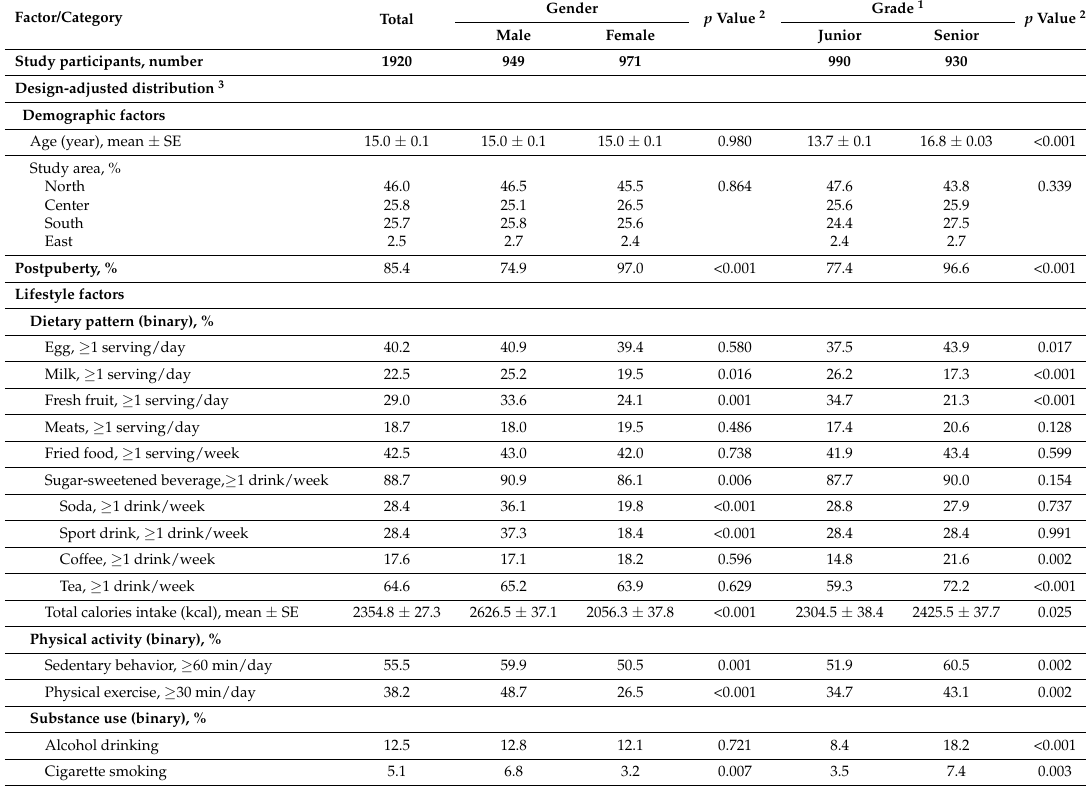
Table 1. Distributions of demographic parameters and lifestyle factors in adolescents,